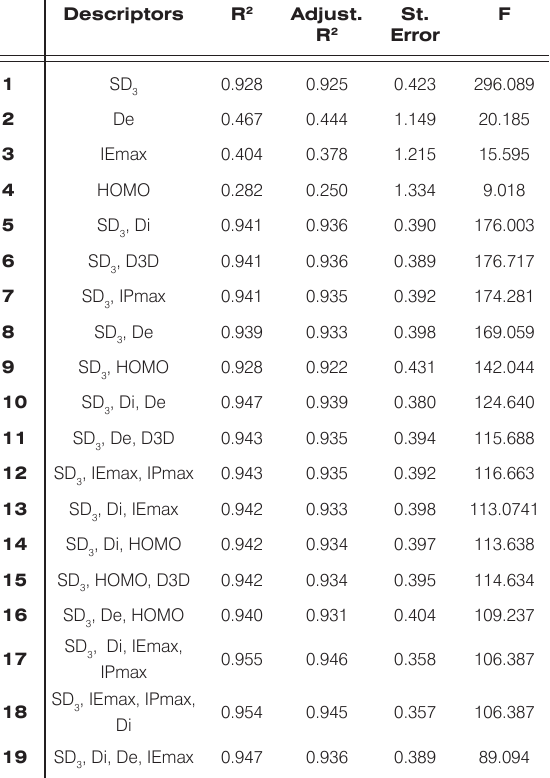
Table 11. Best models in describing log P in the training set of caffeine in Table